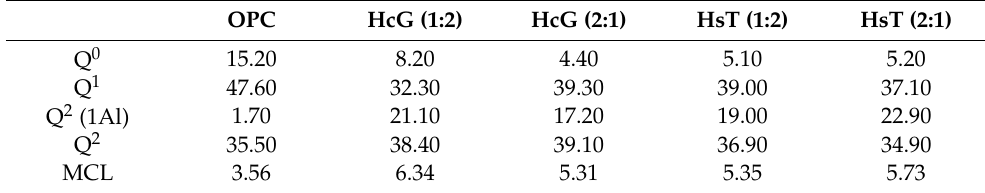
Table 10. 90-day Q n signal deconvolution and MCL compared with